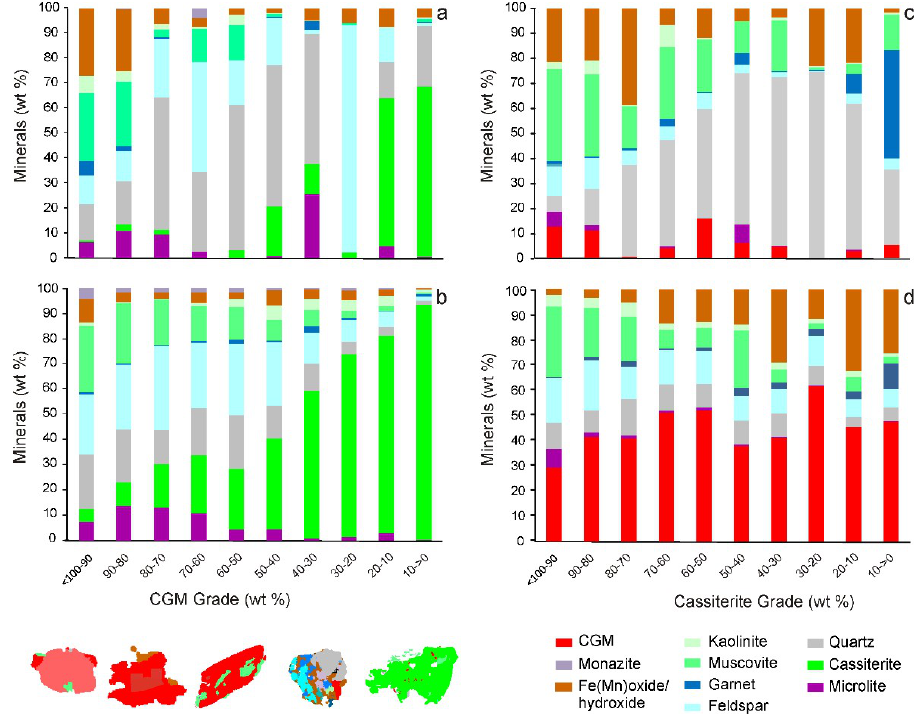
Figure 12. False colour images showing the mineral associations of ores in Penouta concentrates. ( a ) columbite-group minerals (CGM) from Balsa Grande tailings; ( b ) CGM from leucogranite; and ( c ) cassiterite from Balsa Grande tailings; and ( d ) cassiterite from leucogranite.